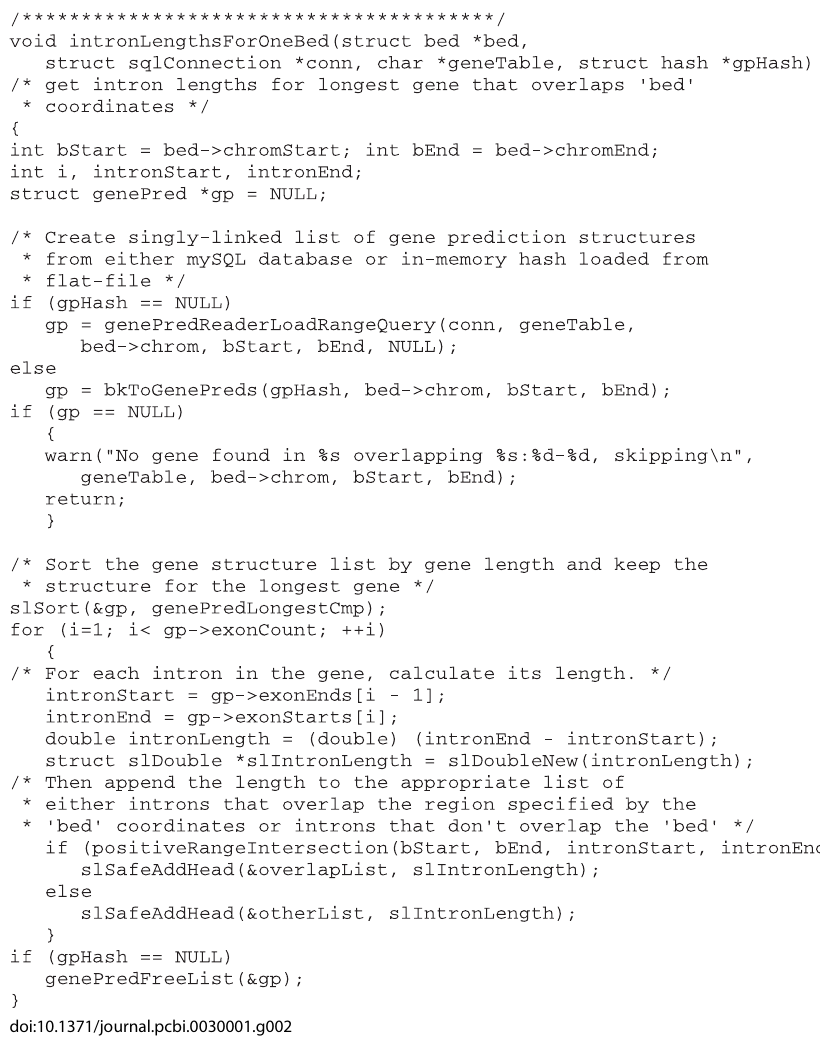
Figure 2. Subroutine Calculating Intronic Lengths, Illustrating C Structures, and Library Routines from the Kent Source Code Tree Subroutine is part of the sample program in Dataset